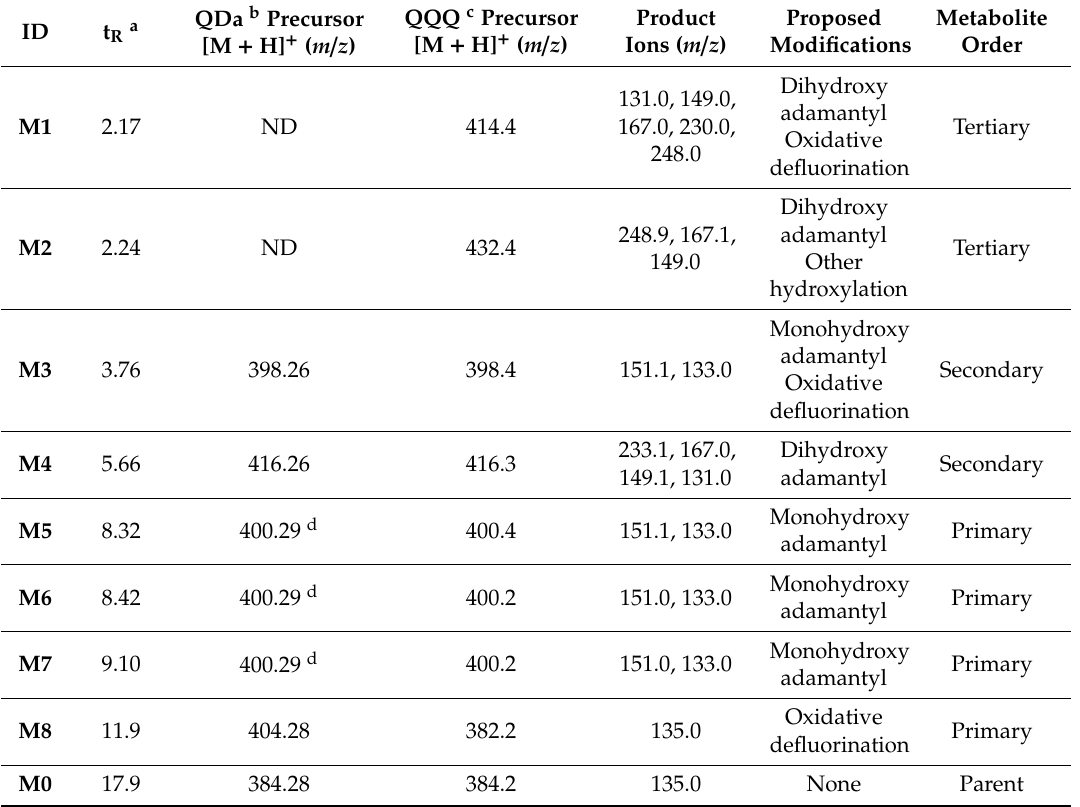
Table 1. Analyte MS data from 5F-APINACA metabolism by human liver